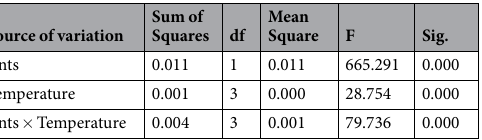
Table 4. Analysis of variance of the available honeydew mass excreted by mealybug with ant tending and temperature.